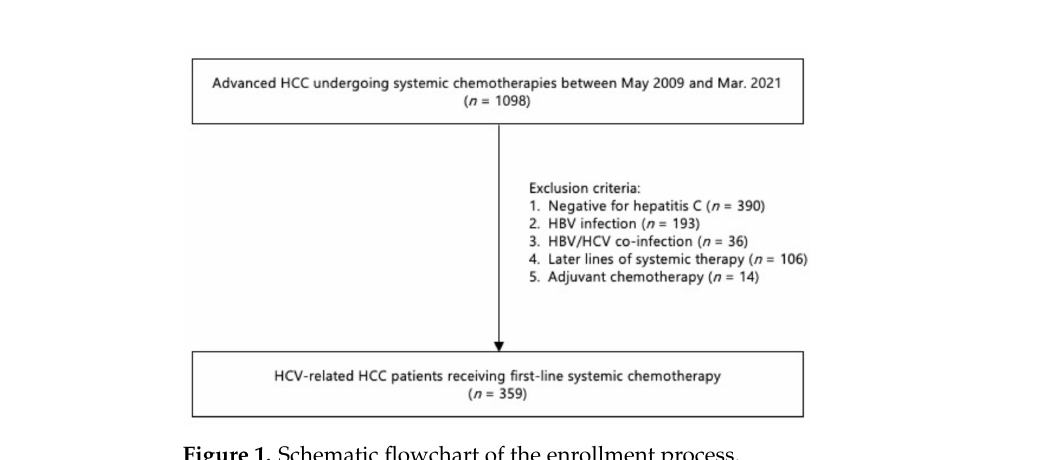
Figure 1. Schematic flowchart of the enrollment process. Table 1. Baseline Characteristics of